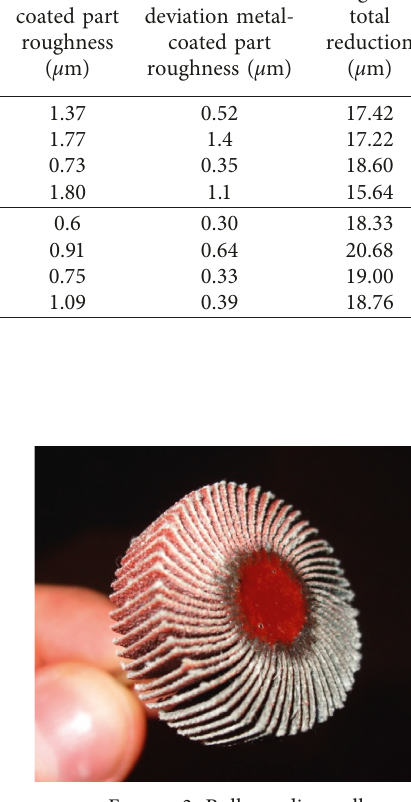
Figure 3: Bulk sanding